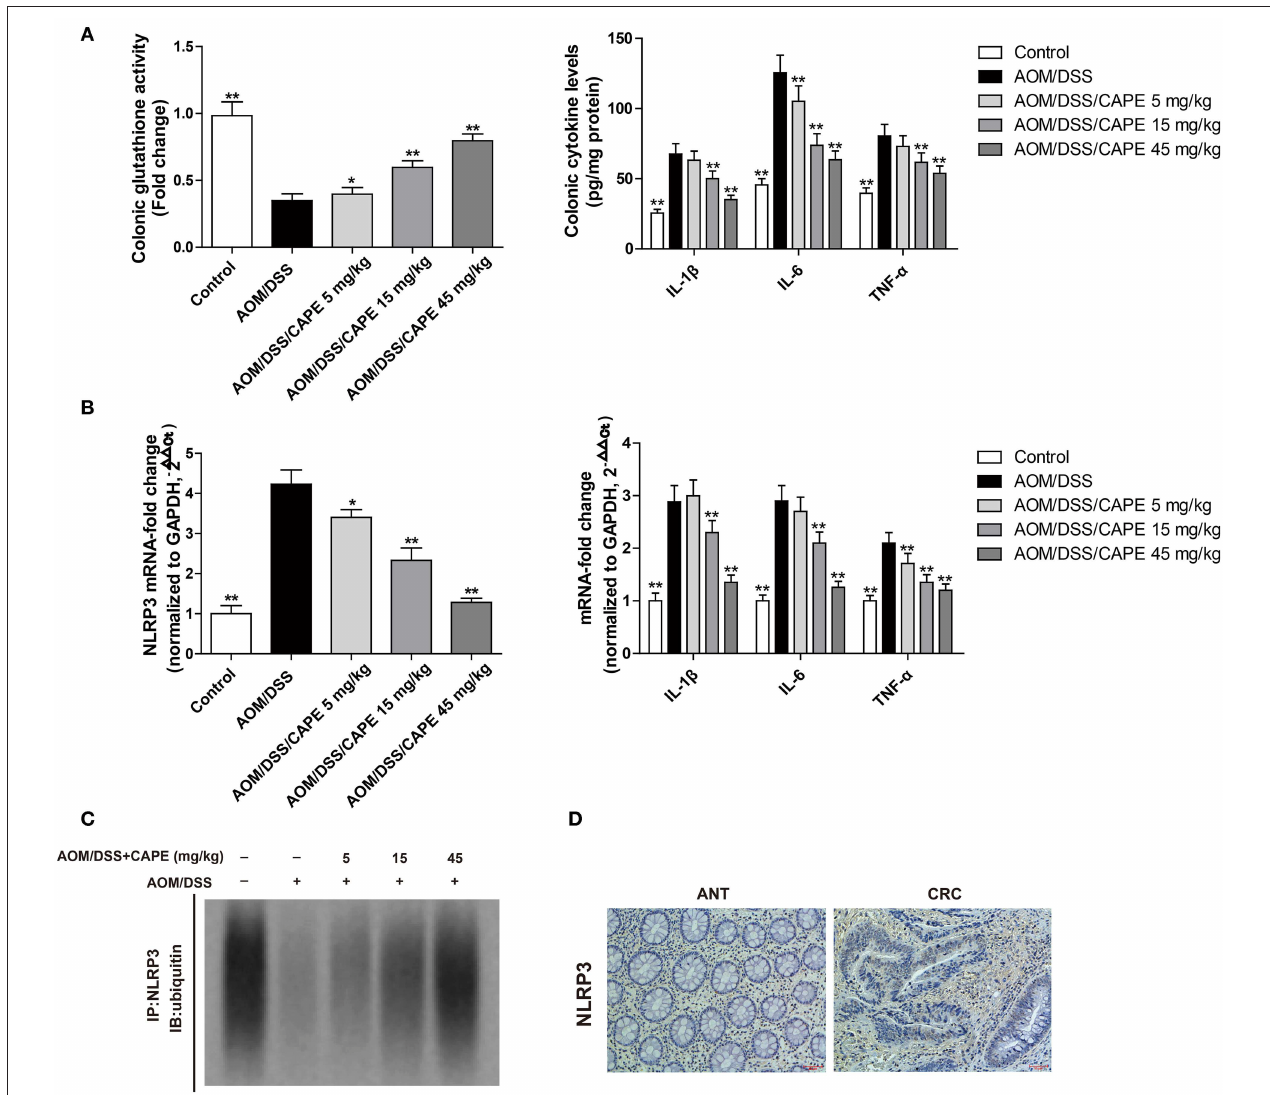
FIGURE 6 | CAPE increases NLRP3 ubiquitination in the AOM/DSS mouse model. (A) Effect of CAPE on the activity of glutathione and the production of IL-1 β , IL-6, and TNF- α . (B) Real-time PCR for determining mRNA levels of NLRP3, IL-1 β , IL-6, and TNF- α . (C) Tissue extracts were subjected to immunoprecipitation with an anti-NLRP3 antibody, followed by immunoblotting with an anti-ubiquitin antibody. (D) Immunohistochemistry of NLRP3 expression in tumor and adjacent tissue of patient with colorectal cancer. Data are presented as mean ± SD ( n = 3). * P < 0.05, ** P < 0.01 vs. AOM/DSS group. Scale bar = 50 µ